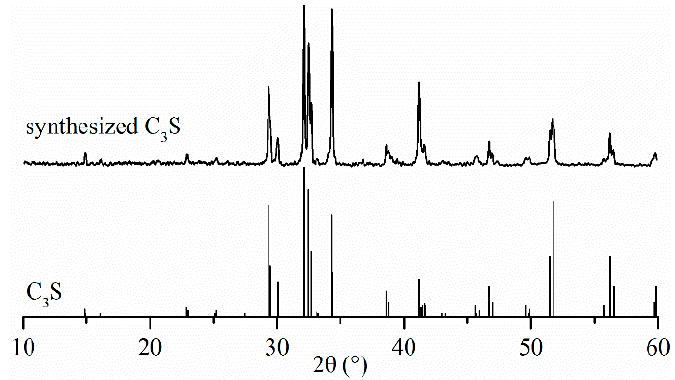
Figure 1. X-ray diffraction (XRD) pattern of synthesized C 3 S.